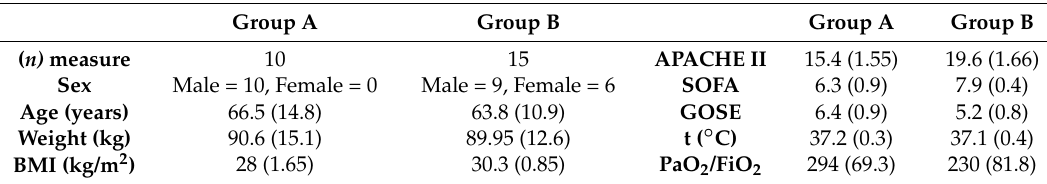
Table 1. General characteristics of the patients included finally in each group Group A Group B Group A Group